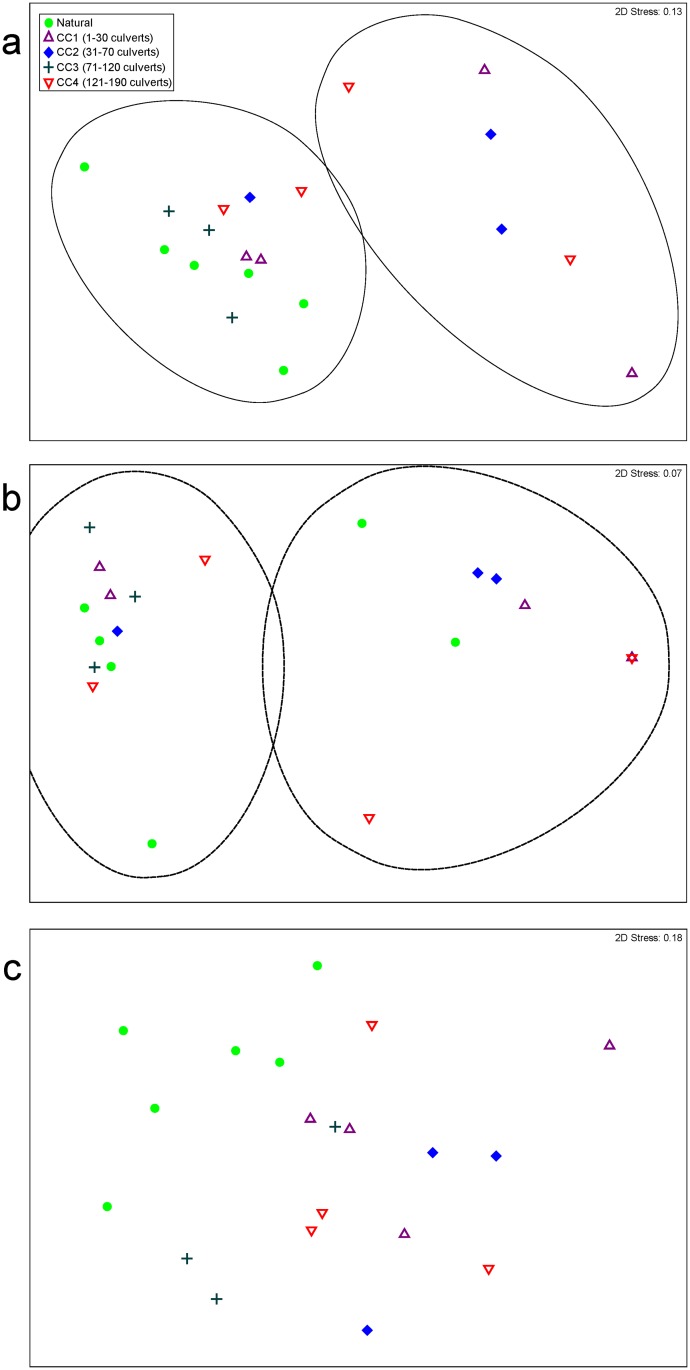
Community composition of (a) all fishes, (b) juvenile fishes, and (c) adult fishes in varying density categories of culvert and natural reefs in 2014.Solid and dashed ovals indicate an overlay of Hierarchical Cluster Analysis that defined two clusters of samples as being significantly different from one another. Clusters in solid ovals have at least 44% similar communities, and clusters in dashed ovals have at least 20.3% similarity.